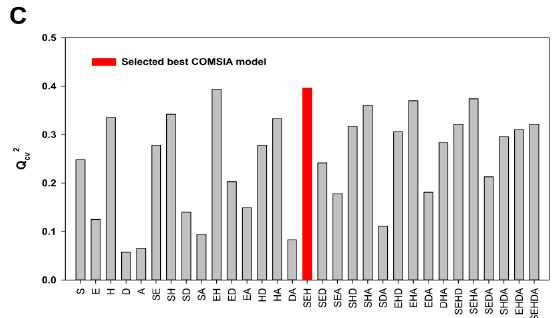
Figure 1. The statistical results of the possible field combinations. ( A ) The Q cv2 values of the ligand-based CoMSIA models; ( B ) The Q cv2 values of the DFT optimization-based CoMSIA models; ( C ) The Q cv2 values of the docking-based CoMSIA models.